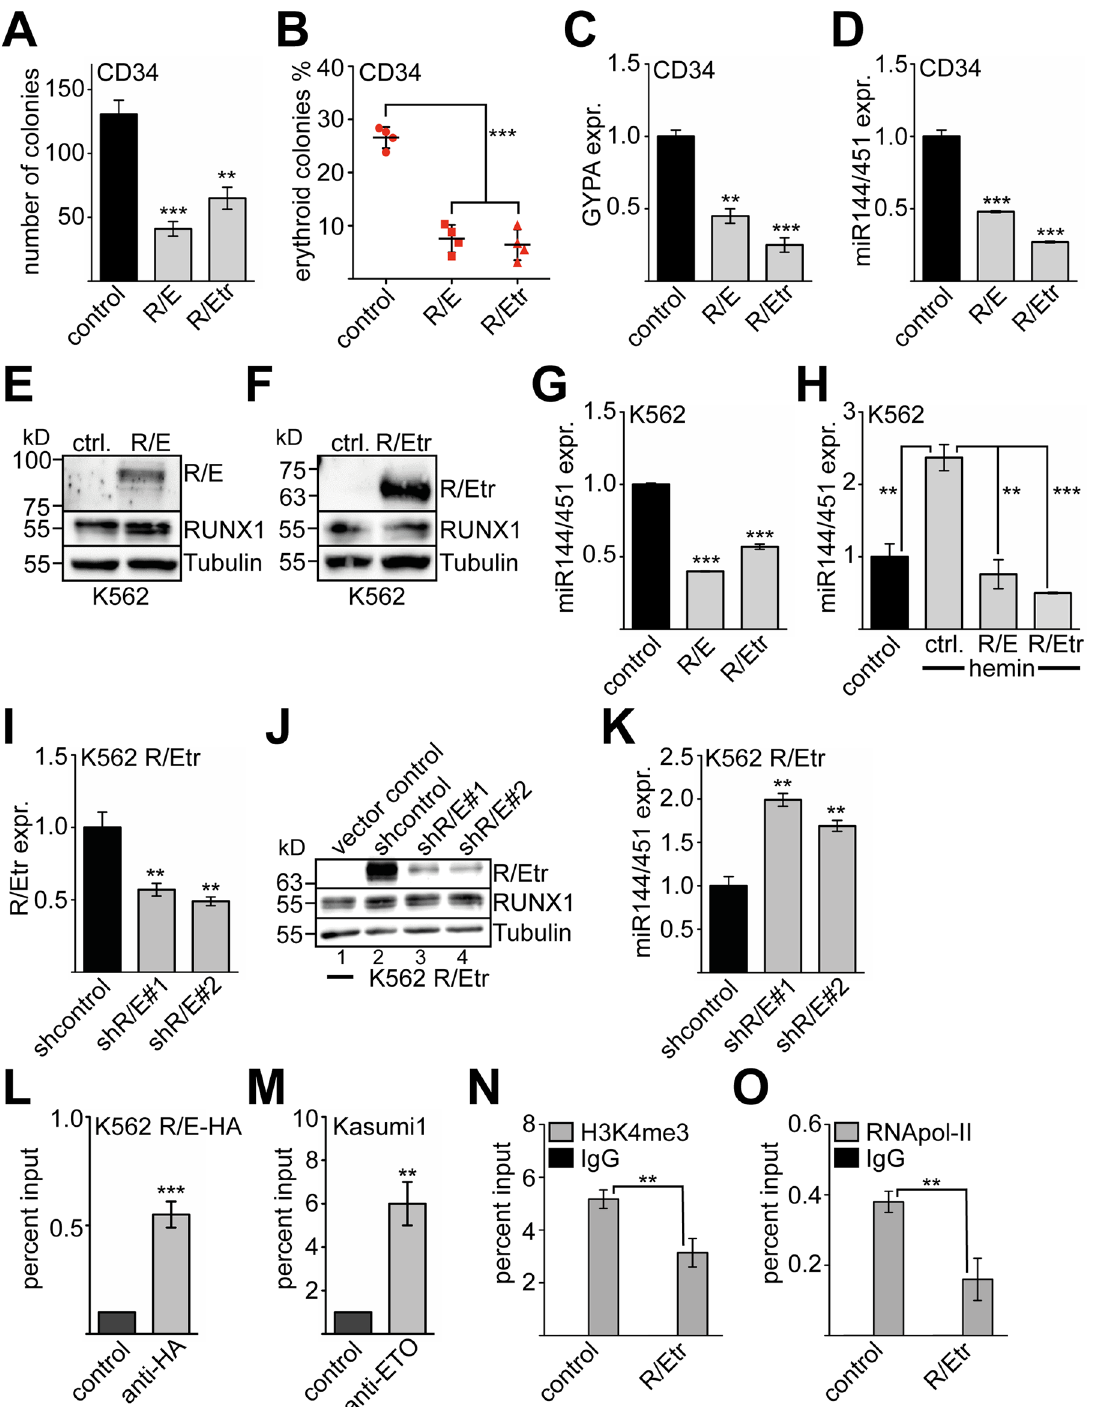
Fig 5. RUNX1/ETO inhibits miR144/451 expression during erythroid differentiation. (A) Colony formation assay with sorted GFP-positive transduced hCD34+ cells shows that full-length RUNX1/ETO (R/E) and RUNX1/ETOtr (R/Etr) inhibit colony formation. The average number of colonies per experiment is given. The error bars give the standard deviation from four independent experiments. (B) The percentage of erythroid colonies is reduced in a colony formation assay upon transduction of hCD34+ cells with R/E or R/Etr. Shown is the relative abundance of erythroid colonies in percent. (C) Expression of the erythroid marker gene GYPA is reduced on the mRNA level upon transduction of hCD34+ cell with R/E or R/Etr, as measured by q-RT-PCR. (D) Expression of the pri-miR144/451 is reduced upon transduction of hCD34+ cells with R/E or R/Etr, as shown by q-RT-PCR. (E) Expression of full length RUNX1/ETO